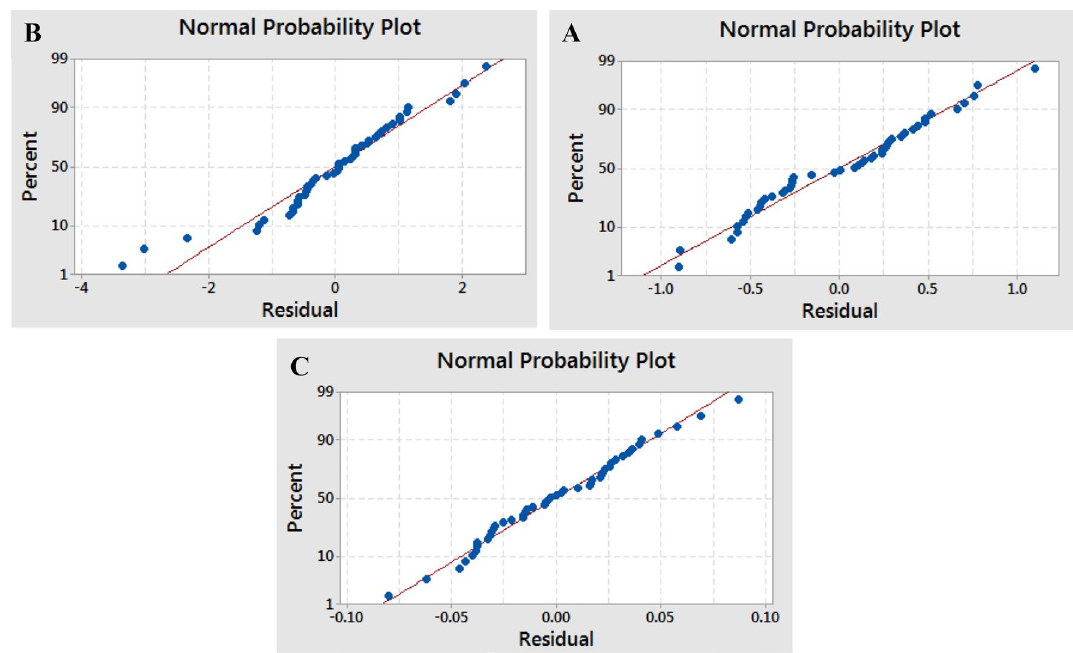
Fig. 5 The diagram of probability of normal residues based on ascending order for a cumulative oil production, b cumulative water production, c net present value